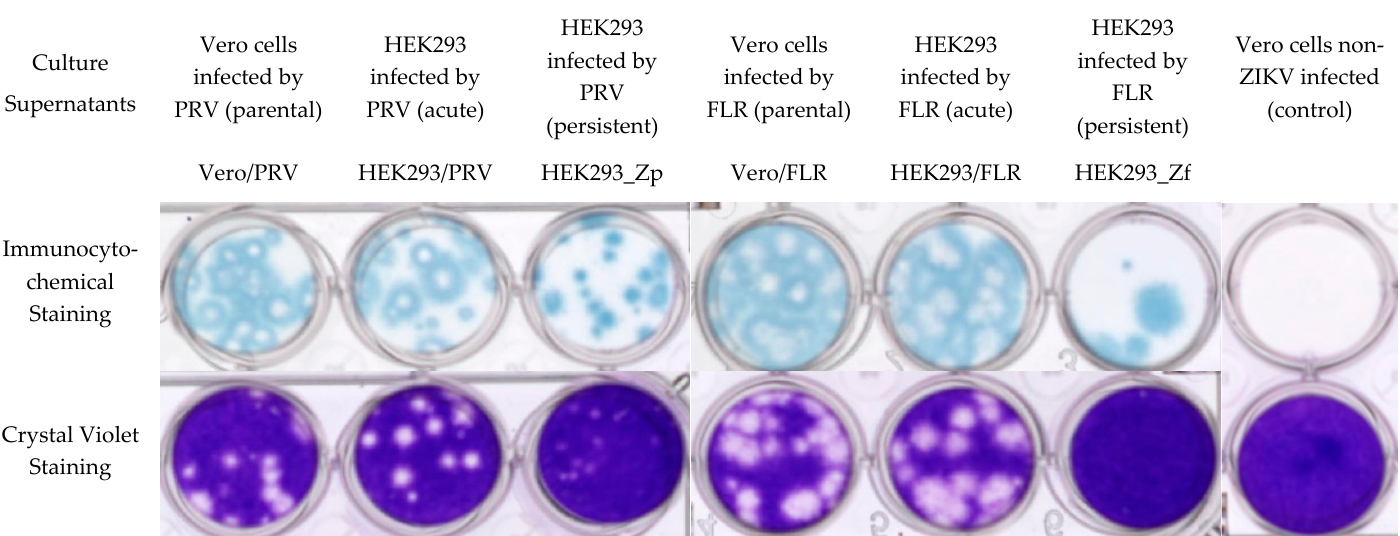
Figure 6. Vero cell cultures infected using ZIKVs collected from the supernatants of acutely and persistently PRV and FLR strains of ZIKV-infected HEK293 cell cultures. Vero control cells as well as Vero cells infected by ZIKVs (PRV_V, PRV_H, Zp_H, FLR_V, FLR_H, Zf_H) using cell culture supernatants (Vero/PRV, HEK293/PRV, HEK293_Zp, Vero/FLR, HEK293/FLR, HEK293_Zf) with the same genomic copy number were stained four days post infection with True Blue after immunoblotting with Anti-Flavivirus Group antigen monoclonal antibody (Clone D1-4G2-4-15, BEI Resources) followed by goat anti-mouse IgG H&L (HRP). Separate sets of culture wells were stained in parallel with Crystal Violet to better visualize plaques formed by the infection of ZIKVs. Immunocytochemical staining showed that the infection foci produced by HEK293_Zp-generated persistent ZIKV (Zp_H) had poorly-formed lytic centers. HEK293_Zf-generated persistent ZIKV (Zf_H) produced significantly fewer infection foci. Moreover, the infection foci formed by Zf_H had no lytic centers.